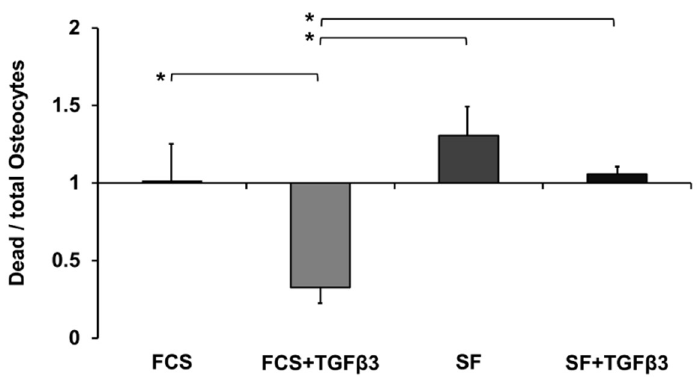
Figure 5. Graph to illustrate the effect of TGFβ 3 on the viability of 3D co-cultured MLO-Y4 osteocyte-like cells. Data—collected on culture day 4—was normally distributed ( n = 3 replicates/experiment, 3 experiments): one-way ANOVA and Tukey were used as statistical analysis. Statistical significance was defined as * p < 0.05. Bar chart shows the average osteocyte death and standard error of the mean.